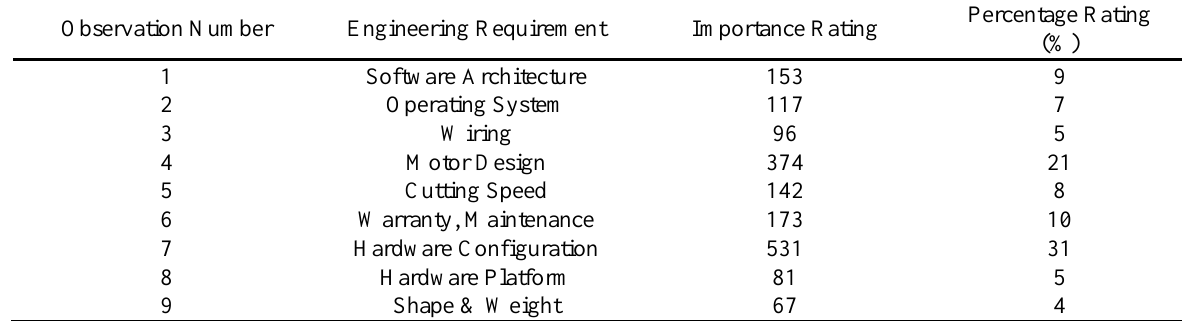
Table 2. Importance